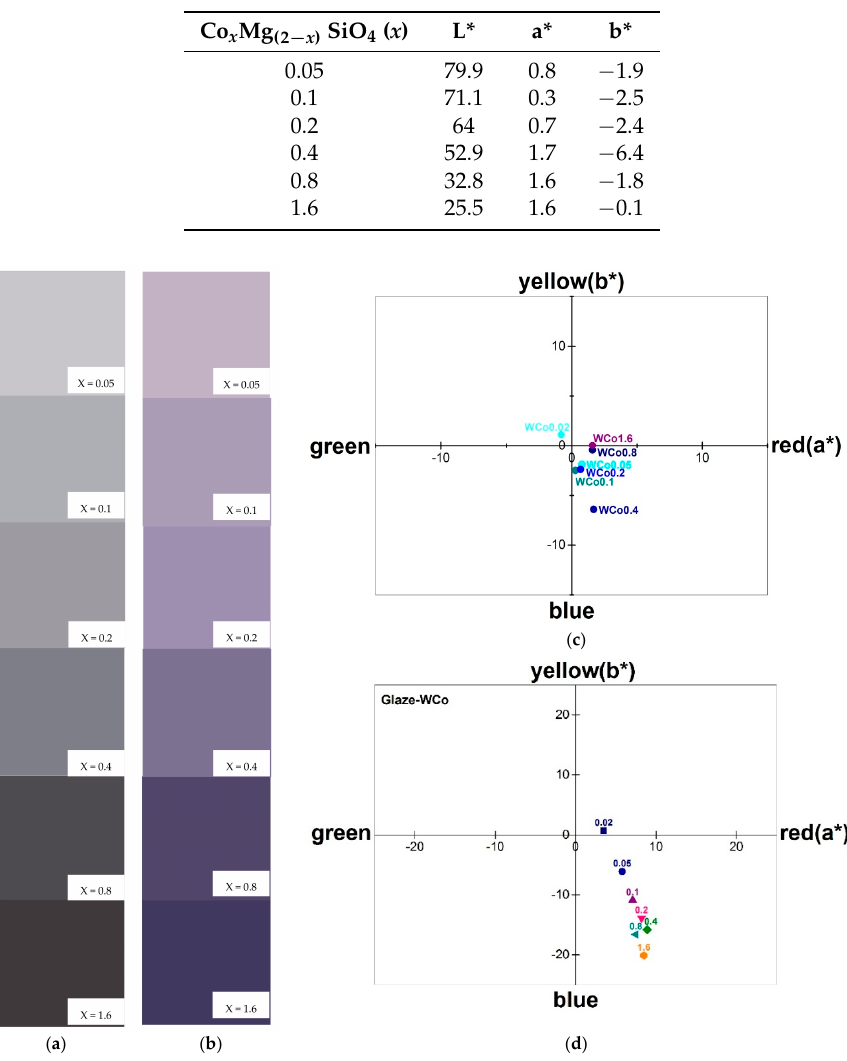
Figure 8. Chromatic tone and CIEL*a*b* diagram of Co x Mg (2 − x ) SiO 4 (where x = 0.05–1.6): ( a , c ) As- calcined powder; ( b , d ) Mixing glaze fired